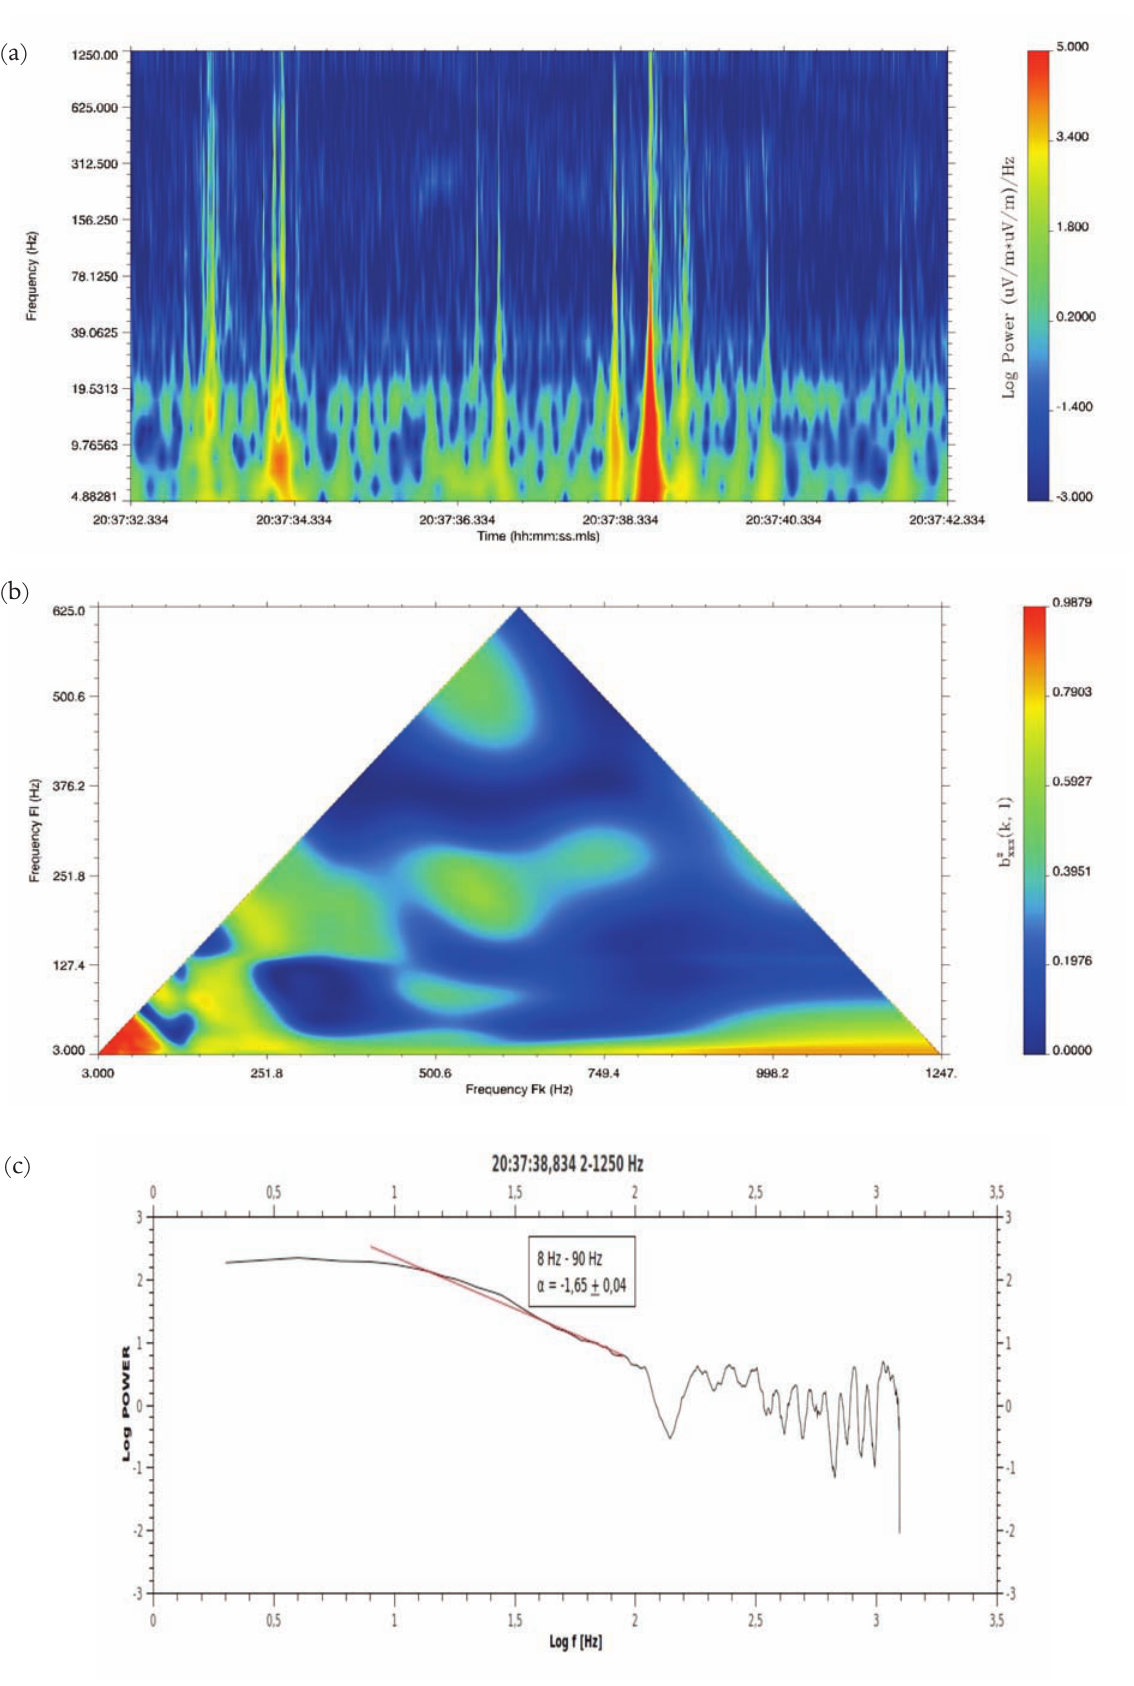
Figure 2. (a) Wavelet spectra up to 1250 Hz of the electric field taken by the DEMETER satellite on April 1, 2009, during burst mode, between 20:37:38 and 20:37:39 UT. The color scale represents the log of the power density of the electric field variations. (b) Bispectrum of the Ex signal in the ELF range. The horizontal and vertical axes of the frequencies of the waves are considered to find the interacting modes. The color scale represents the value of the bicoherence as a function of the frequencies. Two regions of strong 3-wave interactions can be seen: one in lower frequency range, and the other between 150 Hz and 400 Hz. (c) Single spectrum with slope a c